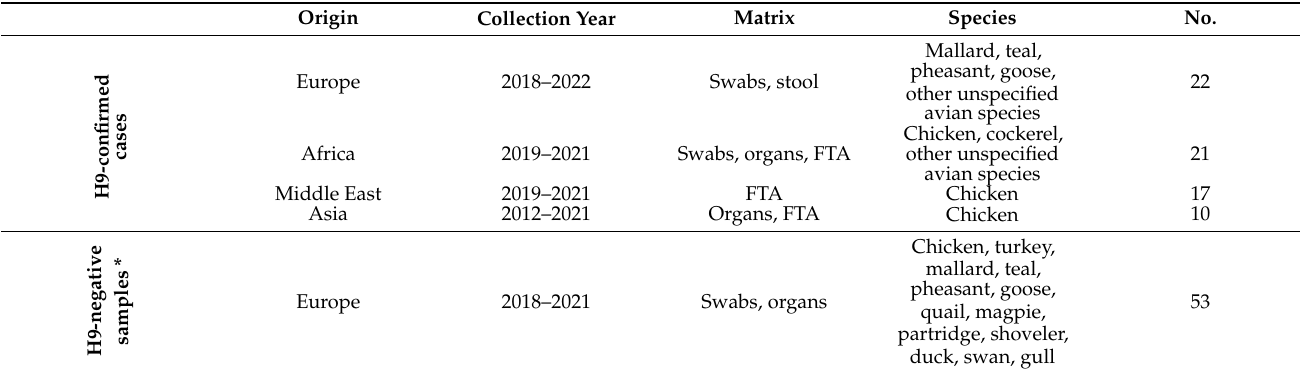
Table 2. Clinical samples with known infectious status used to assess DSe and